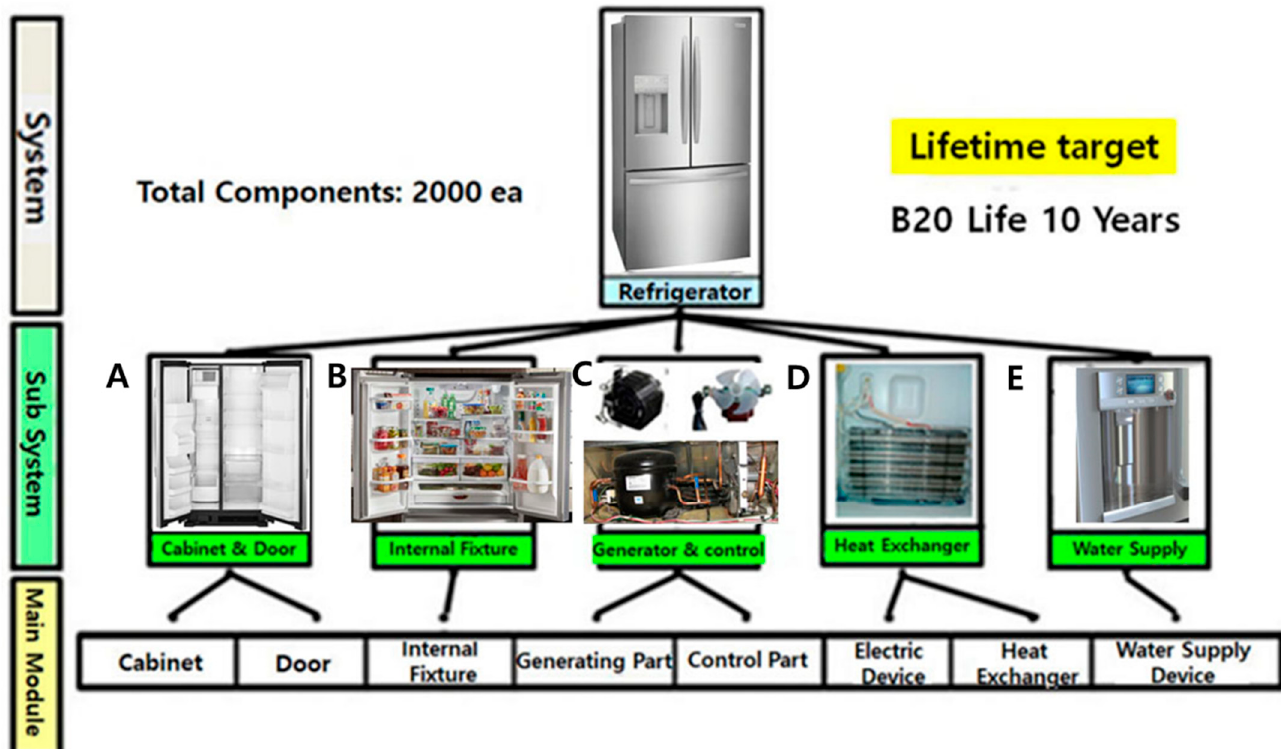
Figure 1. Breakdown of the refrigerator with multi-modules.